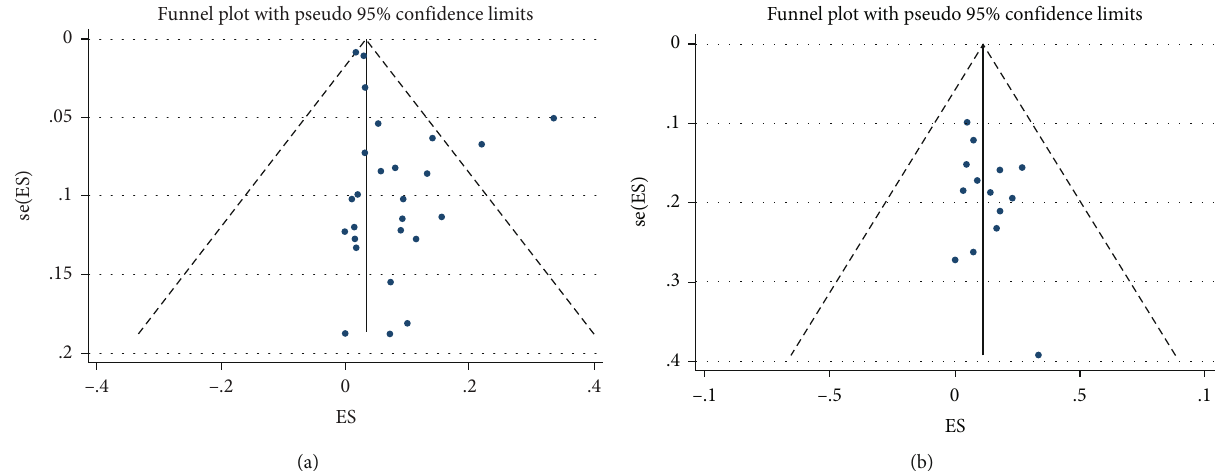
Figure 4: Funnel plot for assessing publication bias in the eligible studies: (a) studies provided data on family history of CRC; (b) studies provided data on family history of